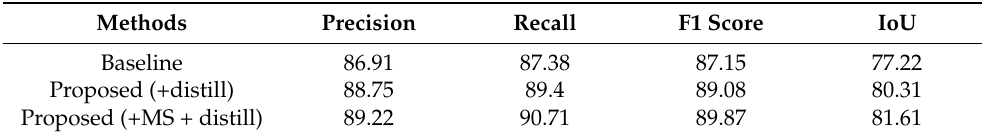
Table 3. Experimental results of overall ablation study.